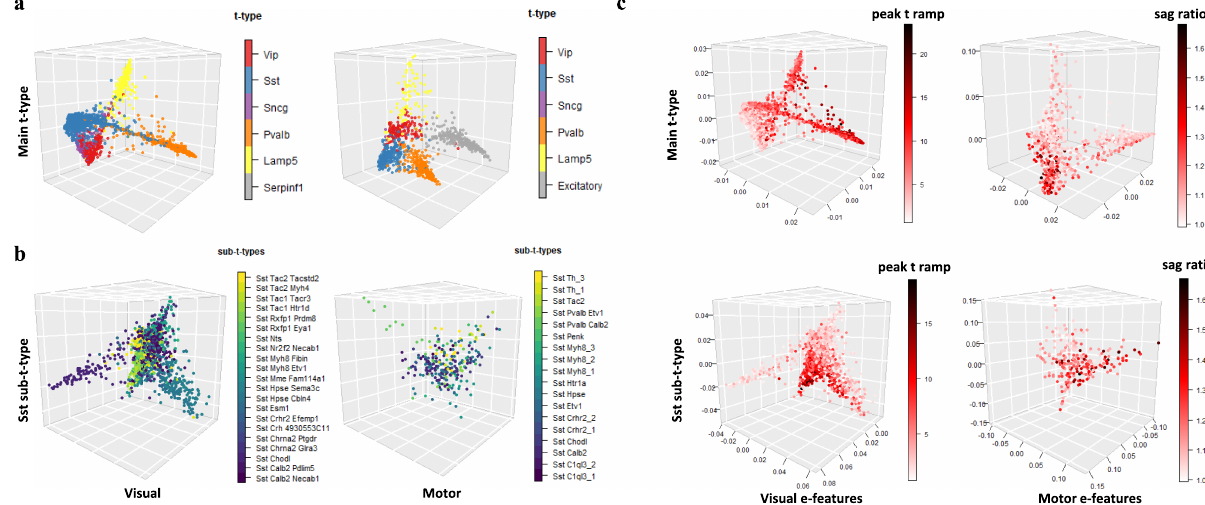
Fig. 3 Trajectories across t-types on the latent space after nonlinear manifold alignment along with continuous electrophysiology changes. a Scatterplots show trajectories across t-types on the latent space (3D used here) after nonlinear manifold alignment of the cells in the visual cortex (left) and motor cortex (right). Cells in shared t-types between two regions are highlighted with the same color for comparison. Red: Vip type; Blue: Sst type; Purple: Sncg type; Orange: Pvalb type; Yellow: Lamp5 type; Gray: other t-types not shared (e.g., Excitatory neurons in the visual cortex). b Scatterplots show trajectories for Sst sub t-types on the latent space (3D used here) after nonlinear manifold alignment of the cells in the visual cortex (left) and motor cortex (right). c Scatterplots show continuous changes of select electrophysiological features in t-types and Sst sub-t-types in the visual cortex (left) and motor cortex (right). The “ peak t ramp ” is the time taken from membrane potential to AP peak for ramp